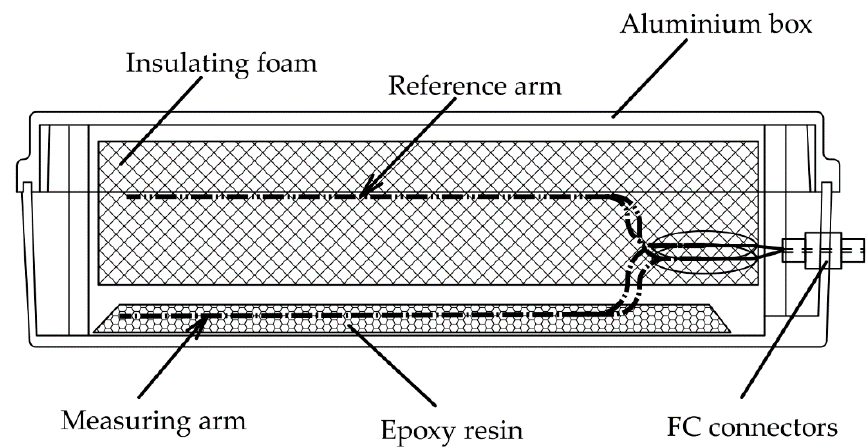
Figure 3. Sensor internal